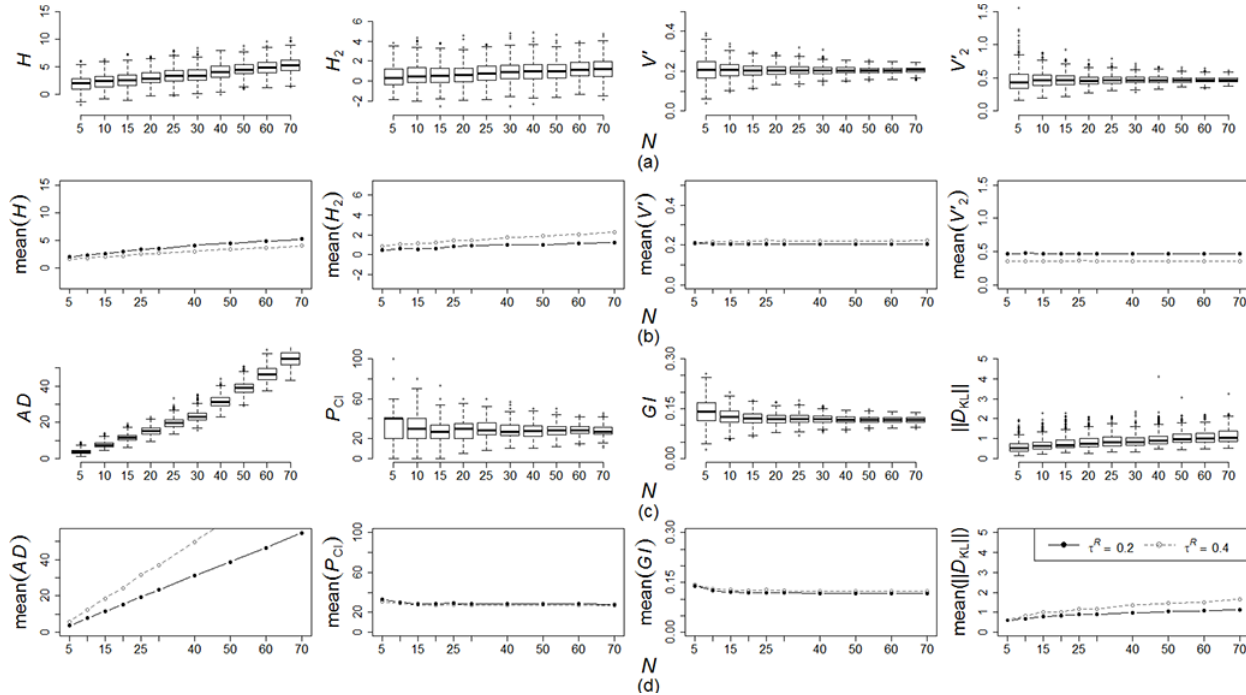
Figure 3. Sensitivity analysis: (a, c) box plots of the heterogeneity measures for N s = 500 simulations of the reference region ( n = 30 and τ R = 0.2), with a heterogeneity rate γ = 50%, varying the number of sites N ; and (b, d) comparison of the corresponding mean with the one obtained by considering τ R = 0.4.